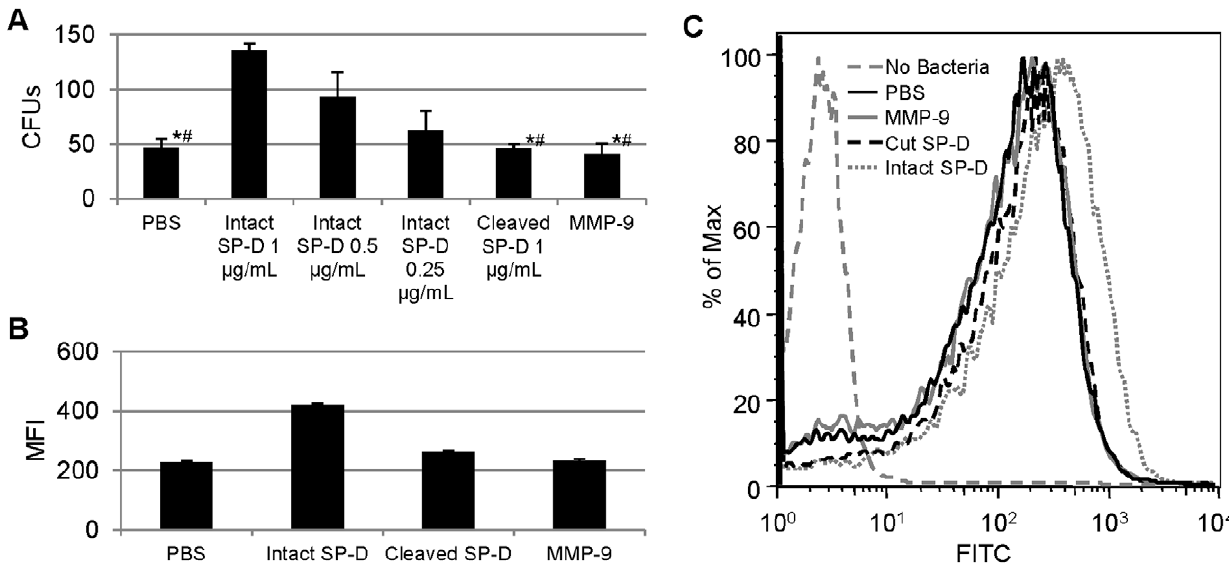
Figure 3. Cleaved SP-D Fails to Increase Phagocytosis by MH-S Cells. Examination and quantitation of phagocytosis of E. coli by MH-S cells was performed using (A) a gentamicin protection assay and (B and C) flow cytometry. For (A), all conditions are significantly different (p , 0.05) from 1 m g/mL intact SP-D. An asterisk (*) denotes p # 0.001 when compared to 1 m g/mL intact SP-D. Columns marked with # are significantly different when compared to 0.5 m g/mL intact SP-D (p , 0.05). For (B), intact SP-D causes MH-S cells to have significantly higher mean fluorescence intensity (MFI) than all other conditions (p # 0.001). Cleaved SP-D is significantly different when compared to both MMP-9 and PBS controls (p # 0.001). For (C), flow data was gated on forward and side scatter to select for MH-S cells. For both (A) and (B), error bars represent standard deviation.